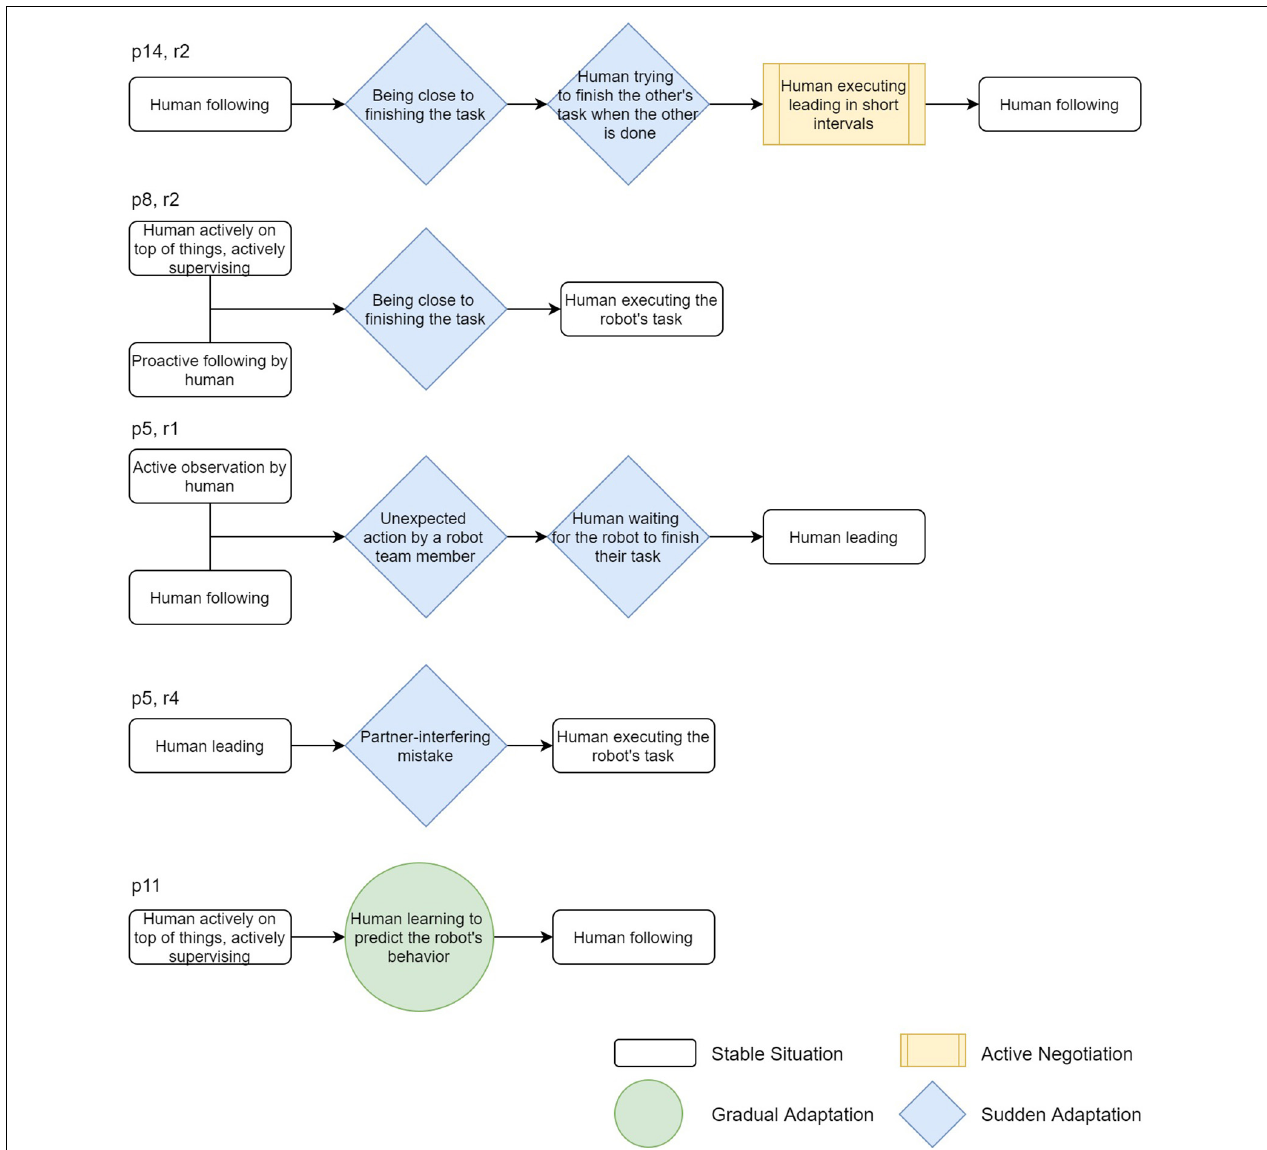
FIGURE 5 | Several example sequences of interaction patterns as they appeared in the